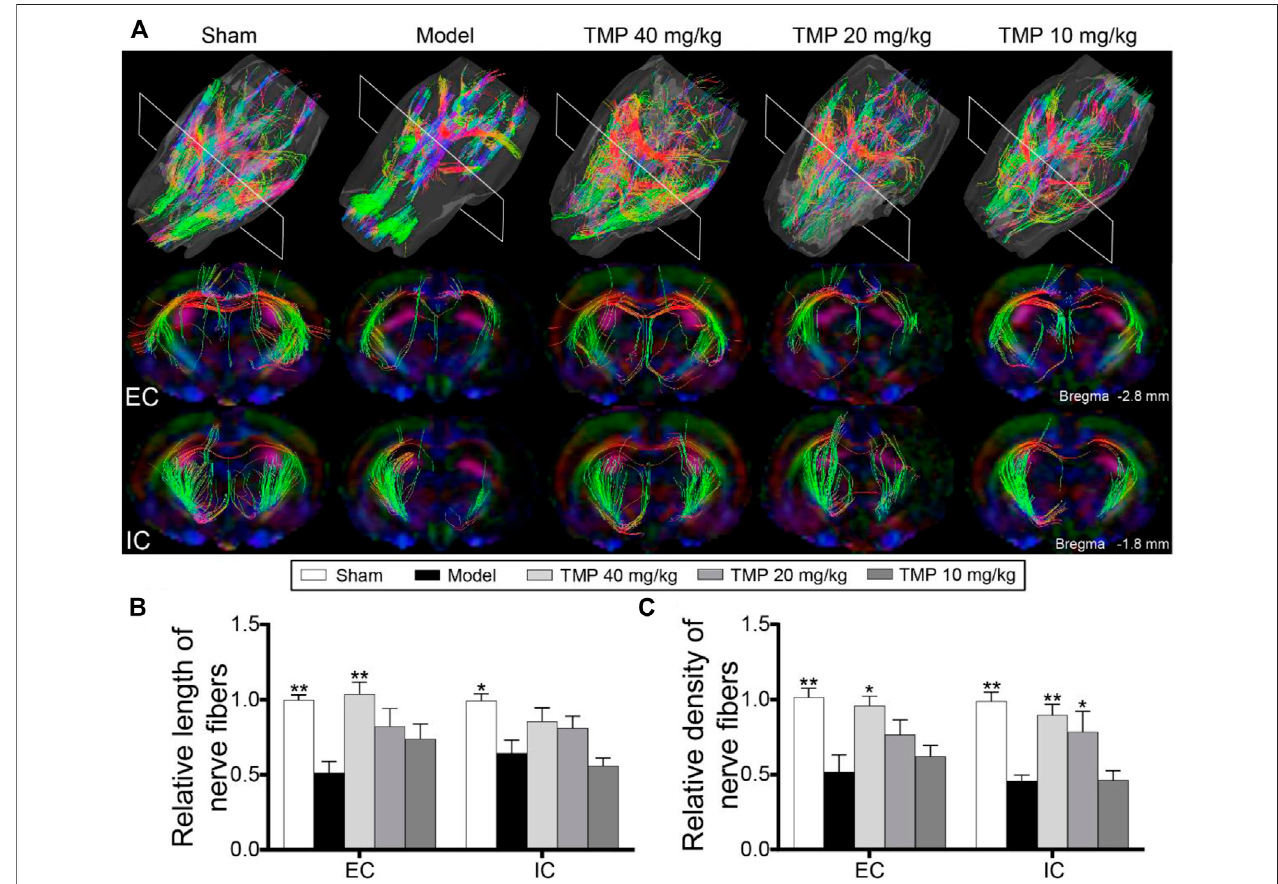
FIGURE4| EffectofTMPonaxonalrestorationinMCAOrats. (A) Typical3DreconstructionDTTimagesofthewholebrainandanatomicalpathwaysoftheexternal capsule (EC) and internal capsule (IC) ofeach group ( n = 6). Quantitation of the (B) relativelength and (C) relativedensity of nerve fi bers in EC and IC. * p < 0.05 and ** p < 0.01 vs. Model